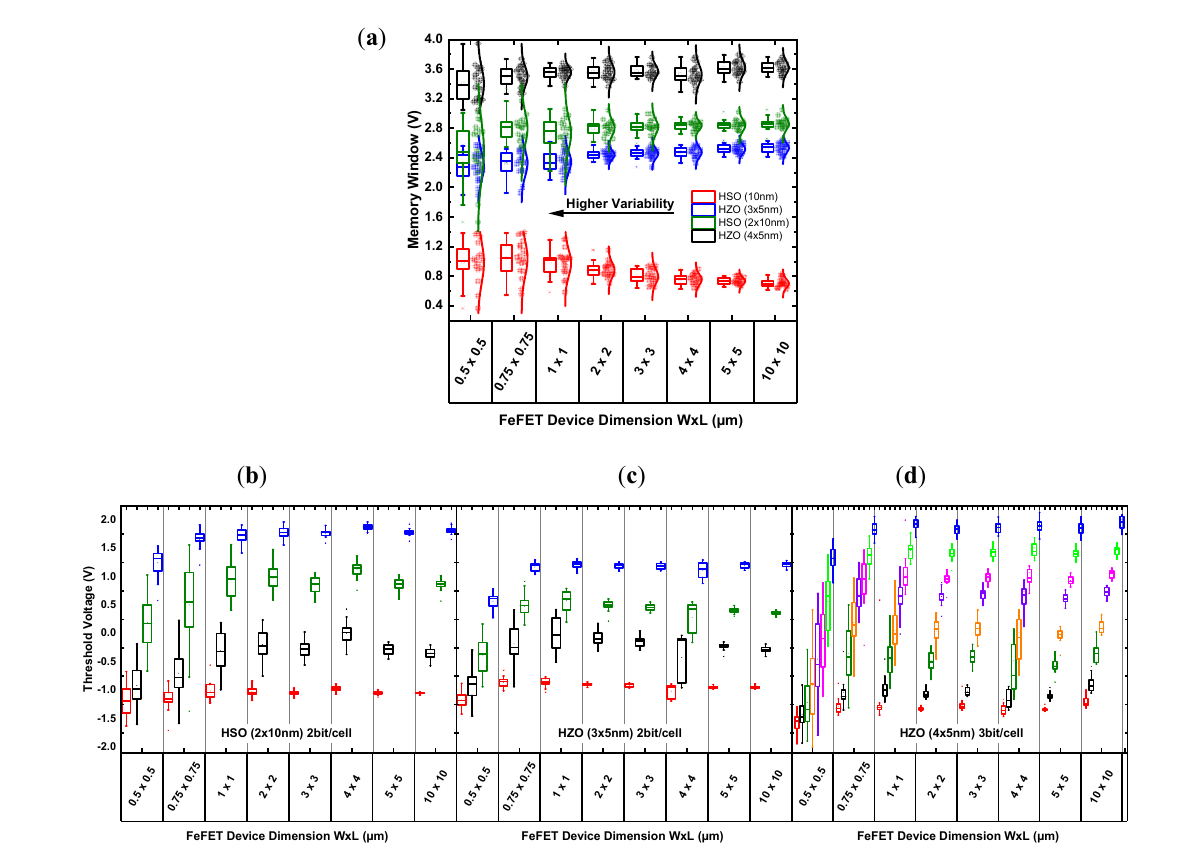
Figure 13. The cross wafer statistical MW/MLC operation in relation to the FeFET area for the different ferroelectric/laminate stacks with ( a ) maximum MW and ( b – d ) the evolution of 2–3 bit threshold voltage levels upon area decrease, ( a – d ) indicates a higher variability in the statistical MLC levels upon area scaling. Reproduced with permission from [17] T. Ali et al., IEDM; published by IEEE, Copyright 2019, IEEE.